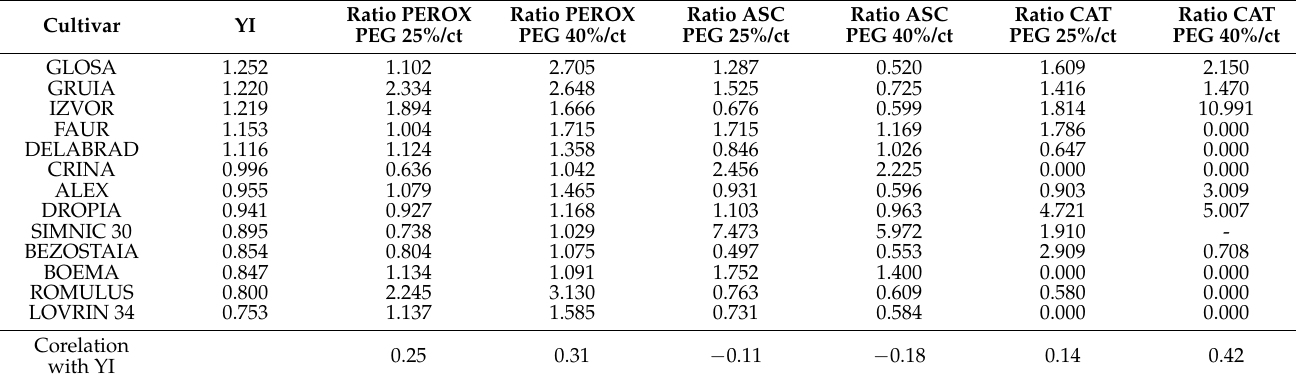
Corelation with YI